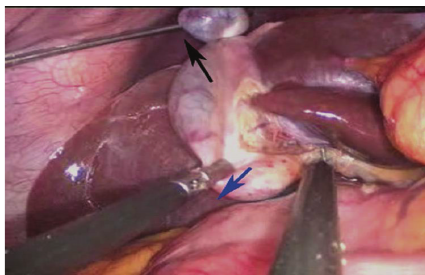
Figure 3: “ On road” to the critical view of safety. Note the inferolateral traction (blue arrow) by left-hand grasper and cranial traction (black arrow) by the port closure needle to expose the cystohepatic triangle.